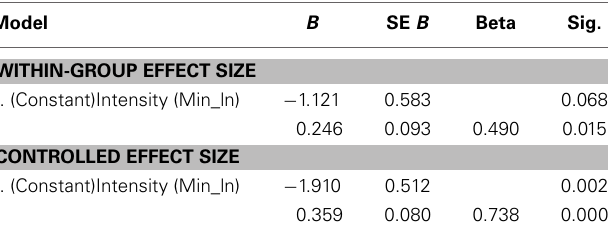
Table 4 | Results of random-effects meta-regression on intensity of mindfulness training for within-group and controlled effect